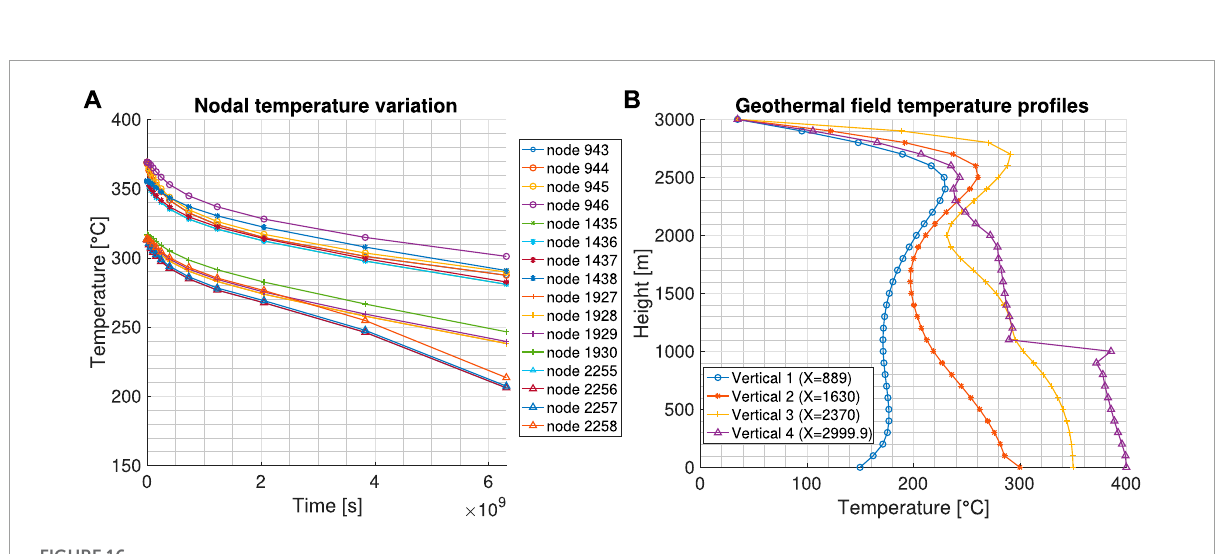
FIGURE 16 Nodal temperature time variation (A) and geothermal field temperature profile (B) with the DBHE in service ( t fin,wb = 200 years )